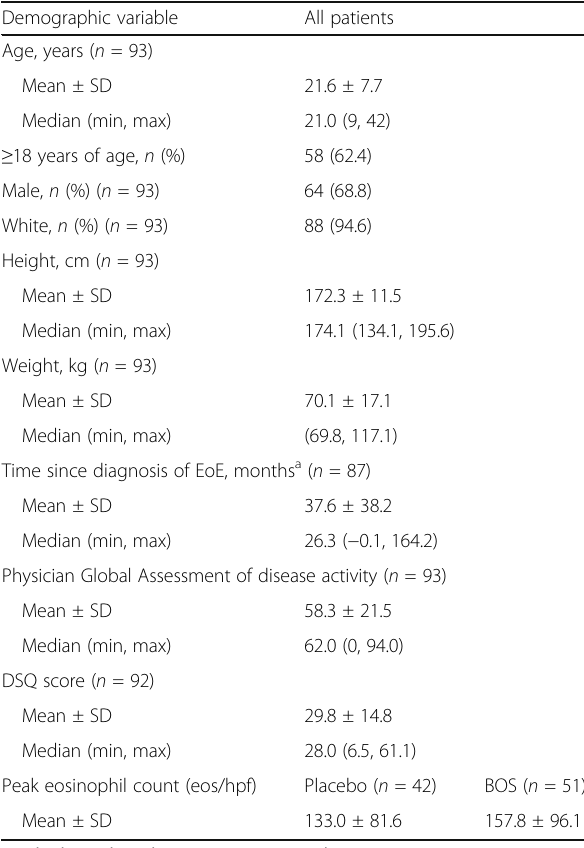
Table 2 Demographic and baseline characteristics for all randomized patients who entered the 12-week